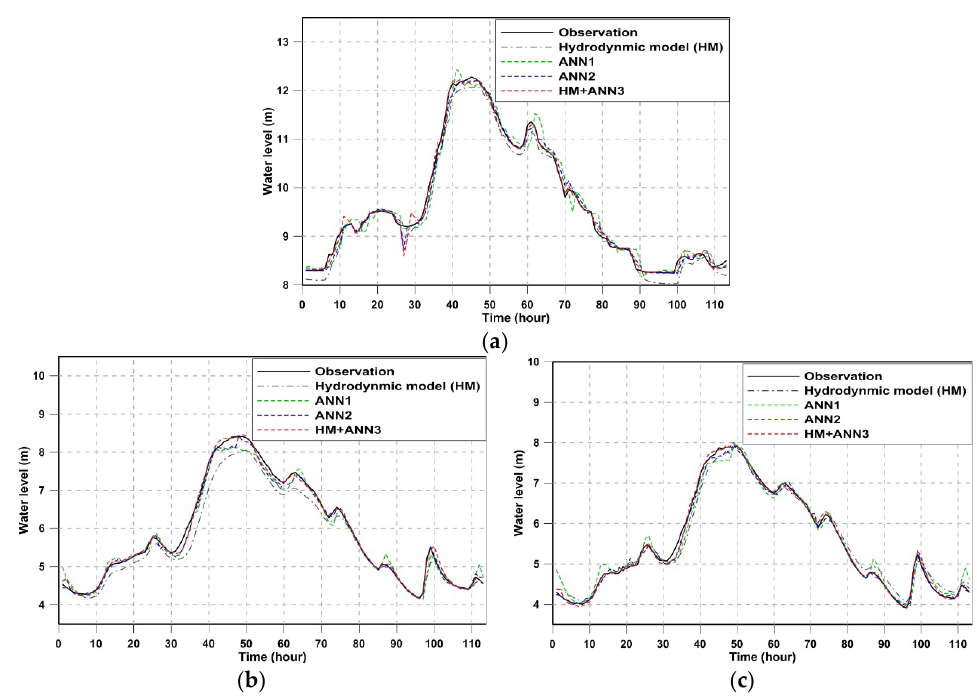
Figure 10. One-hour lead time water levels calculated by various forecasting models for flood event 2 (15 July 2004–19 July 2004): ( a ) Paldang Bridge; ( b ) Banpo Bridge; ( c ) Hangang Bridge.